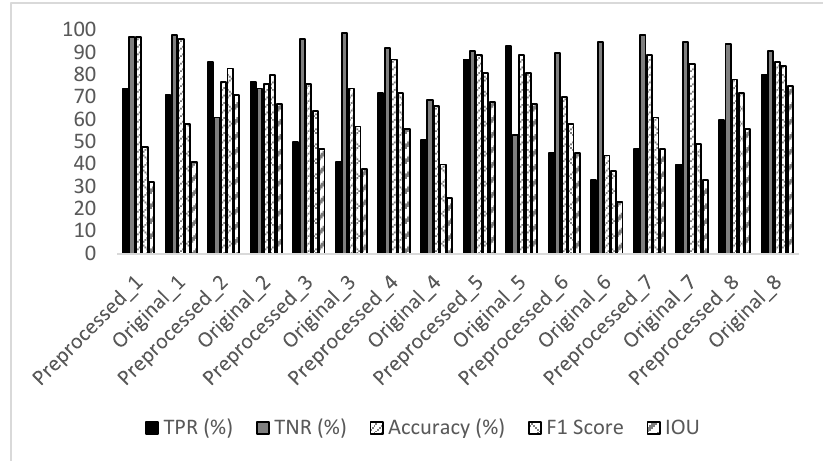
Figure 15. Performance metrics of model .